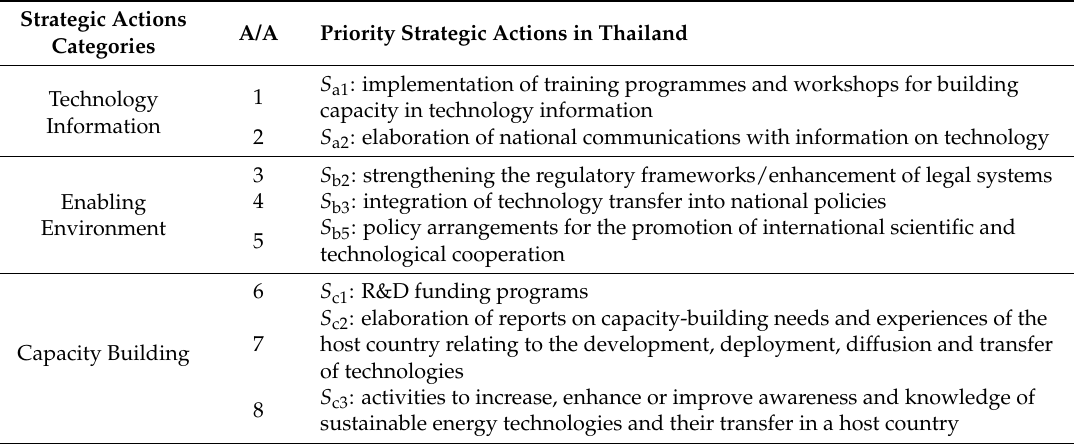
Table 7. Priority strategic actions for the promotion of technology transfer in